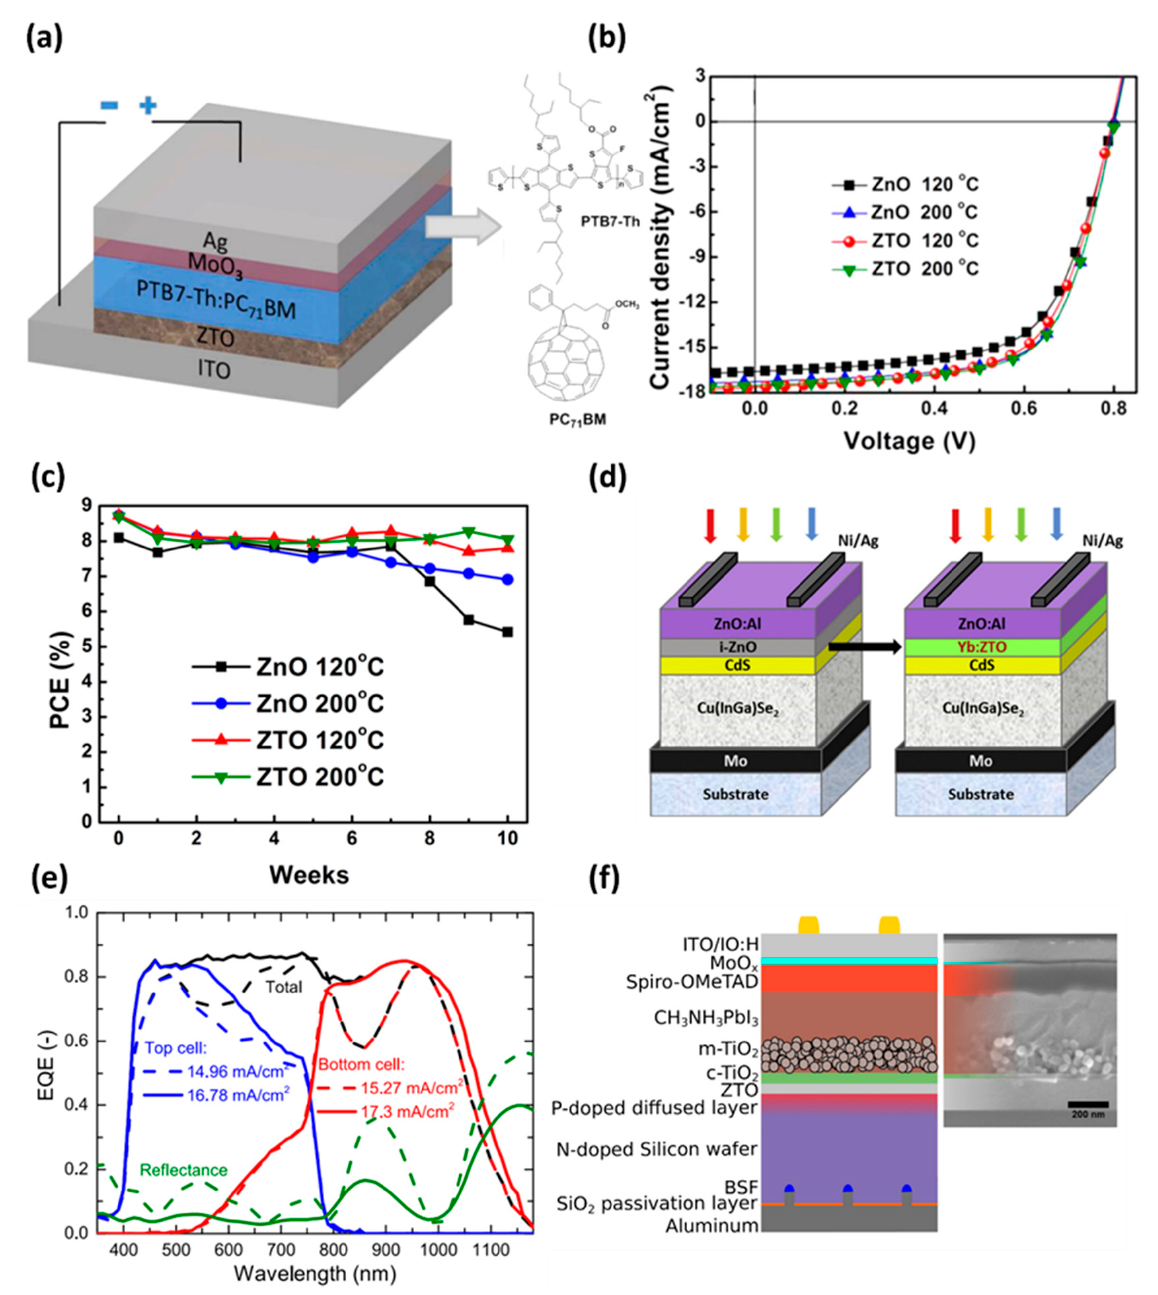
Figure 5. ( a ) Schematic image of ZTO-based device and molecular structures of PTB7-Th and PC 71 BM active layer. ( b ) The J-V characteristics of ZnO and ZTO ETL-based devices depend on the heat treatment temperature. ( c ) Long-term operational stability of fabricated various ETL-based devices (adapted from [79] with permission from the American Chemical Society). ( d ) Schematic illustration of a Cu(InGa)Se 2 -based solar cell using Yb:ZTO as a potential down-converter layer (adapted from [81] with permission from Elsevier). ( e ) J-V characteristics comparing the external quantum efficiency (EQE) of each upper cell and lower cell of the mesoscopic perovskite/silicon homojunction and the total EQE after monolithic integration. ( f ) Illustrated and cross-sectional SEM images of mesoscopic perovskite/silicon homojunction monolithic tandem solar cells integrated using a ZTO buffer layer (adapted from [83] with permission from AIP Publishing).